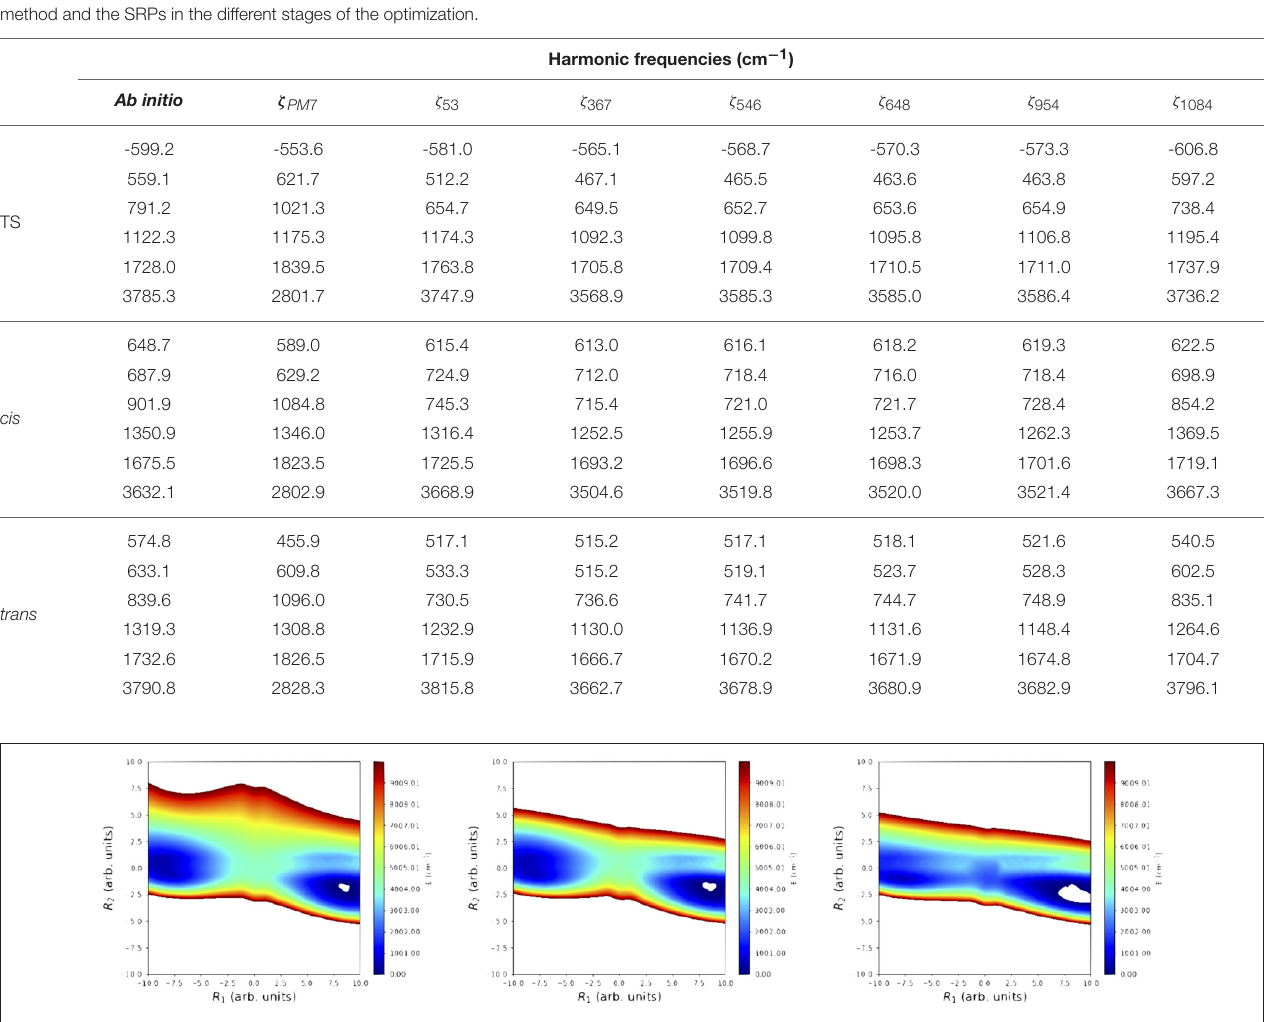
FIGURE 6 | Comparison of the 2D projections of the cis-trans isomerization region for: (i) reference PES (Richter et al., 2004) (left panel); (ii) SRP-PES ( ζ 1084 ) (middle panel); and (iii) PM7-PES (right panel). These projections have been obtained by orthonormalization of two linear interpolation (LIIC) vectors as described in Soto et al. (2006)